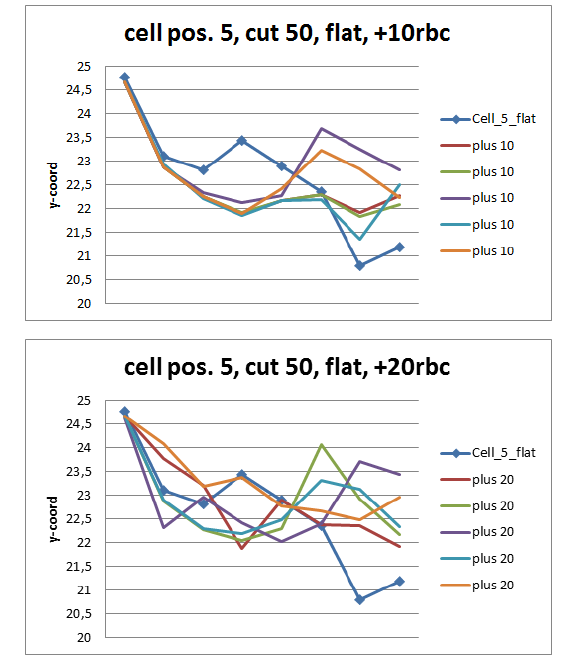
Fig.6. For cutting position 50 + k.100 μm and cell with starting position 5 (25 μm from edge), flat orientation, we can see clear differences between y-coordinate sequences for “solo” experiment and experiments with 10 and 20 randomly added cells